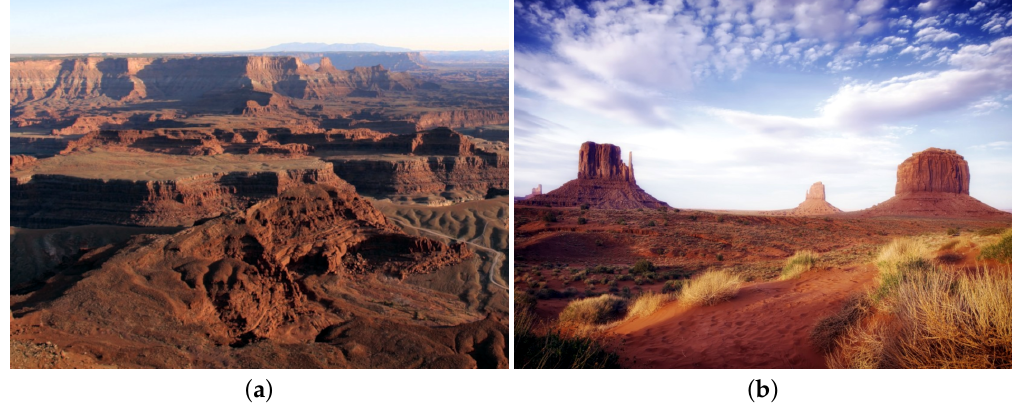
Figure 2. Natural mesa and buttes. Public domain photos found on pxhere.com under the Creative Commons Zero (CC0) license. ( a ) View of the mesa, Dead Horse Point, Utah, USA. ( b ) The Mittens (West, East) and Merick Butte, Arizona, USA.